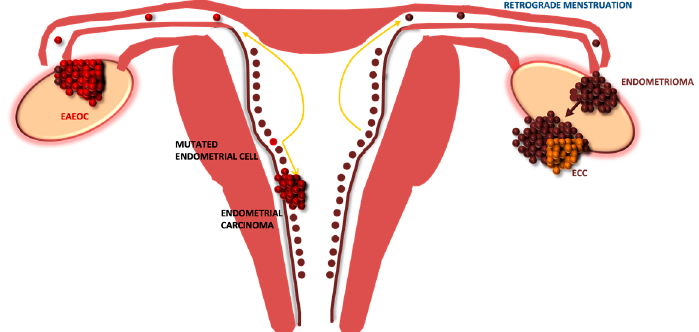
Figure 3. Dichotomy in the histogenesis of endometriosis-associated ovarian cancer histotypes. In EAEOC, the original precursor might derive from the endometrium, while evidence would support ECC carcinogenesis to occur within the endometrioma. EAEOC: endometriosis-associated endome- trioid ovarian carcinoma; ECC: endometriosis-associated clear cell ovarian carcinoma.